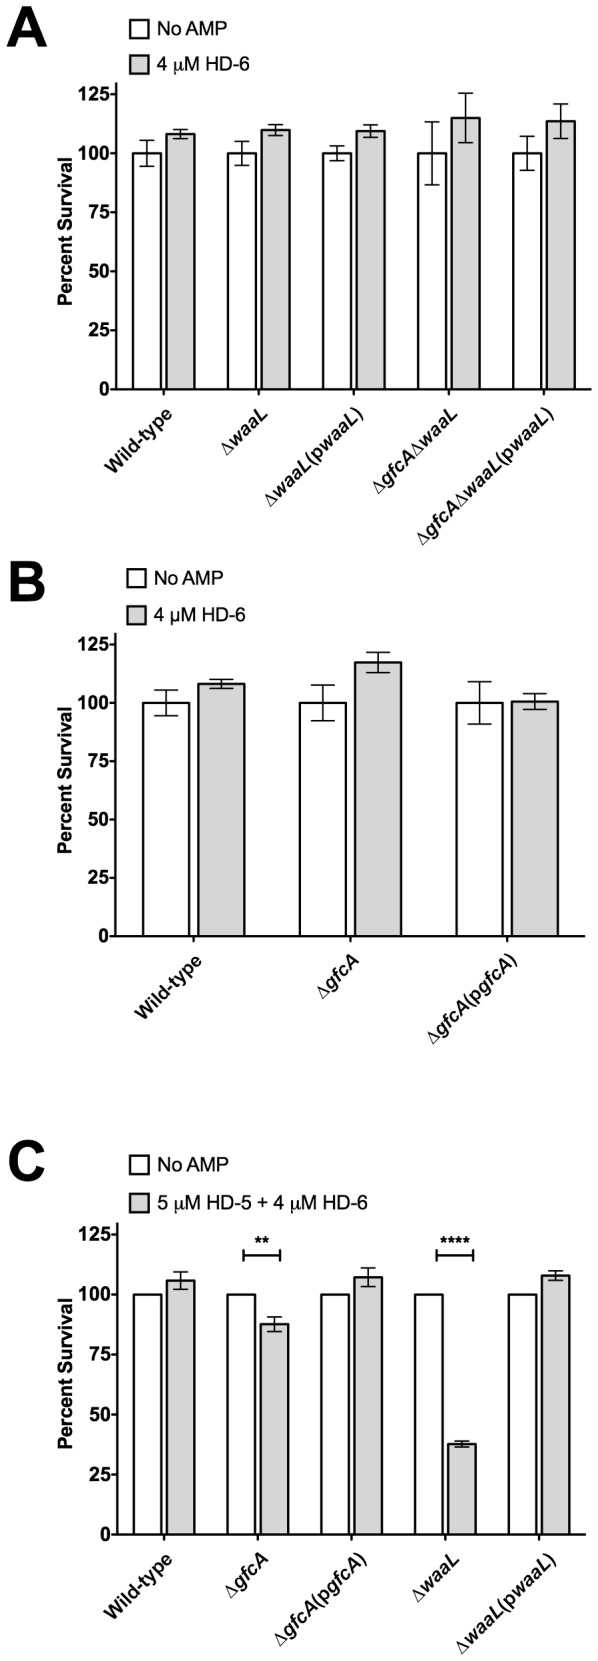
HD-5 and HD-6 do not synergize.Survival of EPEC wild-type, ∆gfcA, ∆gfcA(pgfcA) strains (A) and EPEC wild-type, ∆waaL, ∆waaL(pwaaL), ∆gfcA∆waaL and ∆gfcA∆waaL(pwaaL) strains (B) in the presence of 4 µM HD-6. (C) Survival of EPEC wild-type, ∆gfcA, ∆gfcA(pgfcA), ∆waaL and ∆waaL(pwaaL) in the presence of 5 µM HD-5 and 4 µM HD-6. Results are expressed as means ± SEs of triplicate samples. Data shown are representative of at least three independent experiments. Asterisks indicate statistical significance; **, P<0.01; ****, P <0.0001 by one-way ANOVA and Bonferroni’s multiple comparison post
hoc test.